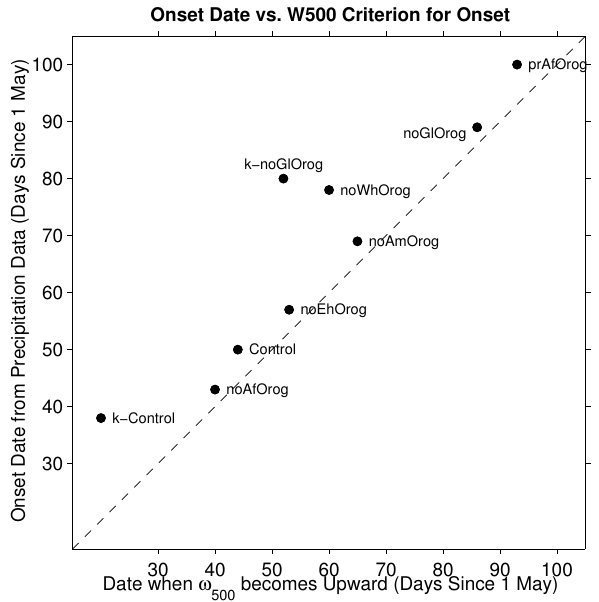
Fig. 22. Onset date vs. the dates when both the criteria of SMSE threshold and organized upward ascent are satisfied. For the simu- lations marked with filled (open) circle the first (second) necessary criterion was satisfied later than the second (first) criterion. Key words starting with k- indicates simulation with Kuo cumulus con-